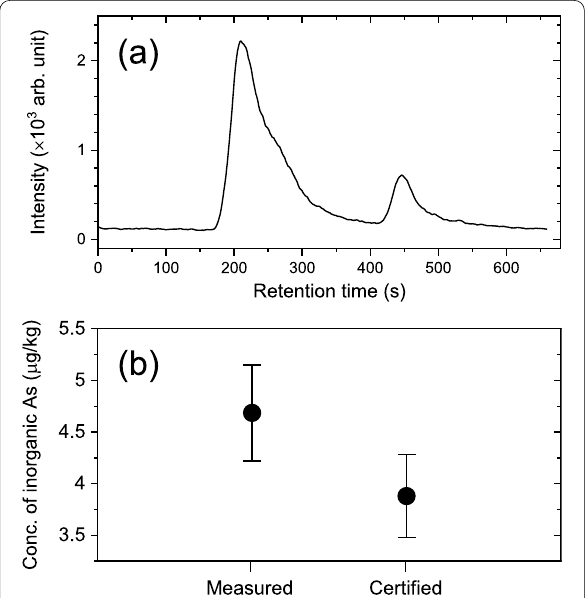
Fig. 4 a Chromatogram of inorganic arsenic in water SRM and b the measured concentration of inorganic arsenic and the certified concentration of As in the SRM